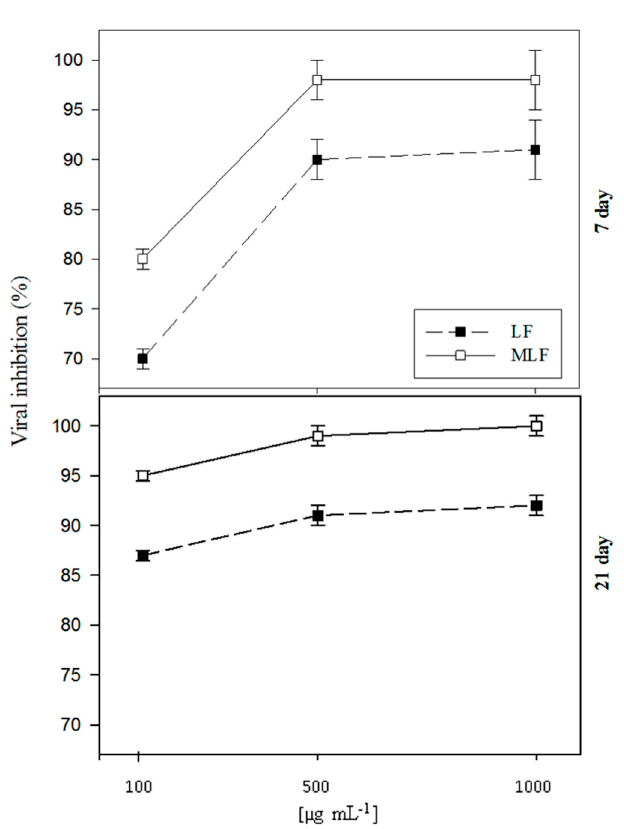
Figure 1. Inhibition of PVY replication into potato plants by foliar spray with lactoferrin (LF) and methylated lactoferrin (MLF) at three concentrations (100, 500 and 1000 µ g · mL − 1 distilled water). The viral load was determined in potato leaves after 7 and 21 days by the double antibody sandwich enzyme linked immunosorbent assay (DAS-ELISA) method. Six representative plant samples out of a total of 15 plants / treatment were used in this analysis and the results were expressed as the means ± SE.